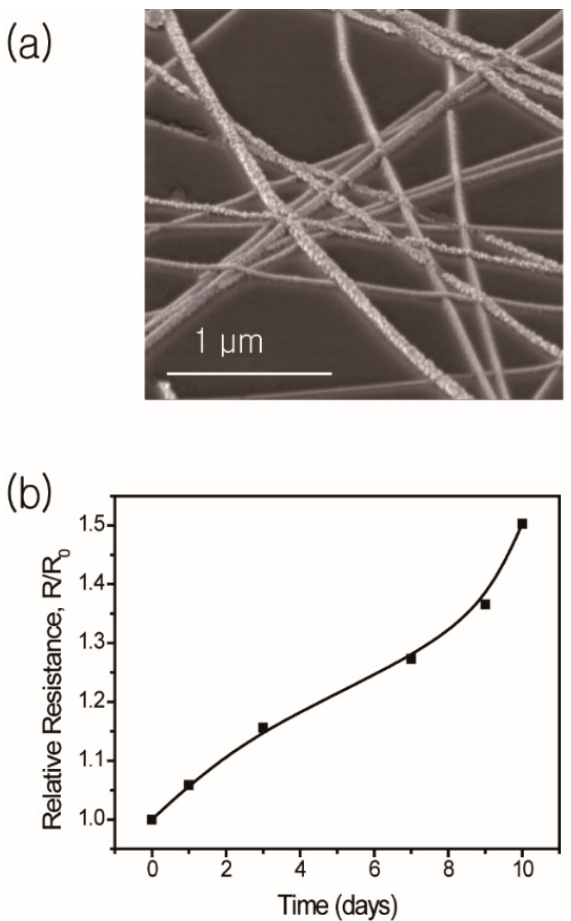
Figure 5. ( a ) SEM image of the Ag NW network by sulfidation and ( b ) the change in relative electrical resistance of the Ag NW network after 10-day exposure to air.